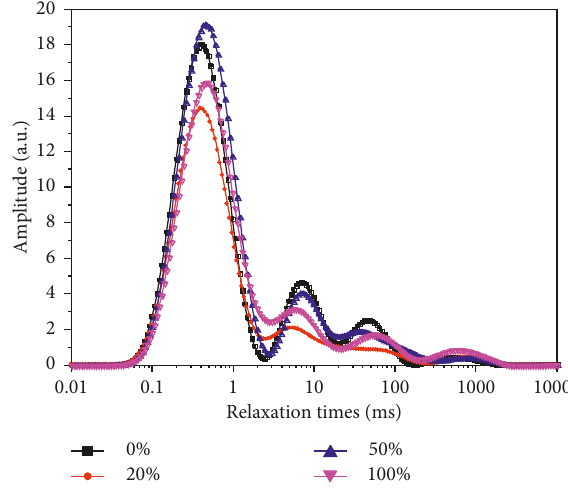
Figure 7: T 2 spectrum distribution curves.